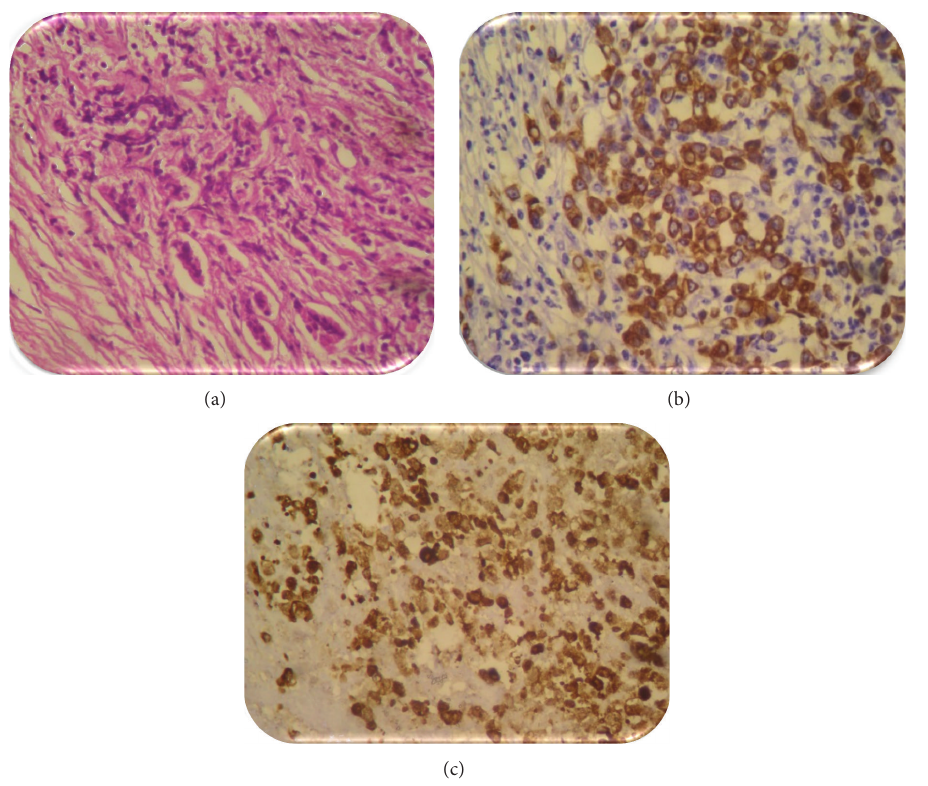
Figure 2: (a) Histopathological findings showed cells difficult to typify (40). (b) Immunohistochemistry of the piece showed intense expression of cytokeratin (AE1/AE3). (c) Expression of CK20 similar to the primary colorectal